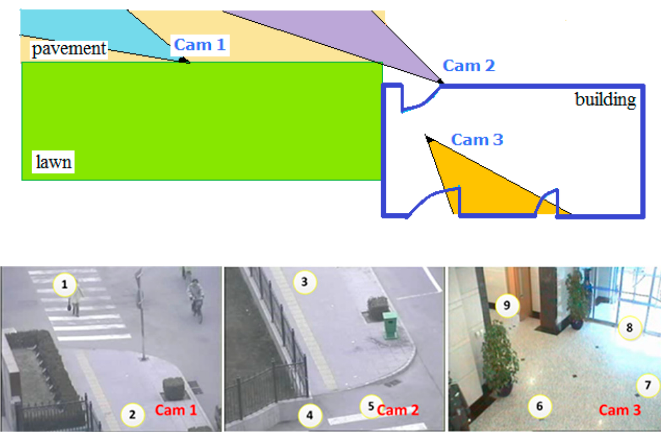
Figure 8. The layout of cameras of subset 1 is shown in the upper image, and the view of each camera is shown in bottom while the numbers denote entry/exit areas. This figure is adapted from:http://mct.idealtest.org/Datasets.html.